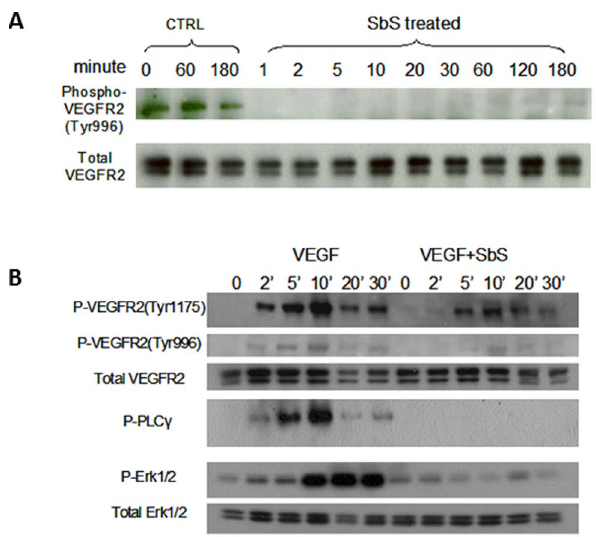
Figure 4. Sb inhibits VEGFR signaling in HUVEC. 4A) HUVEC grown normally in complete medium were exposed to SbS for varying time periods (0–180 minutes). Cell extracts were prepared for Western blotting using antibodies against total and phopho-specific VEGFR-2. The band of phosphorylated VEGFR-2 immediately disappeared (within 1 minute) upon exposure to SbS. In contrast, the amount of total VEGFR2 remained stable. 4B) HUVEC were starved overnight and then treated with 10 ng/ml VEGF in the presence or absence of SbS for 0 to 30 minutes. Cell extracts were prepared for Western blotting with antibodies against total or phopho-specific VEGFR-2, PLC c , or Erk1/2. VEGF induced activation of both VEGFR-2 phosphorylation sites as recognized by p-Tyr1175 and p-Tyr996 phospho-site specific antibodies. The downstream mediators PLC c and Erk1/2 are also activated by VEGF. The presence of SbS inhibited the phosphorylation of VEGFR-2 in response to VEGF and also reduced activation of the downstream kinases PLC c and Erk1/2. Total protein levels were not